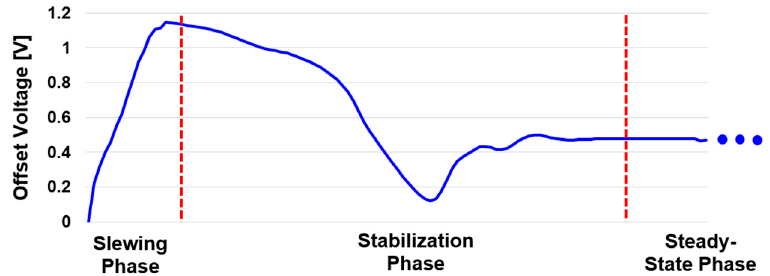
Figure 7. The transient of the offset voltage during amplification.